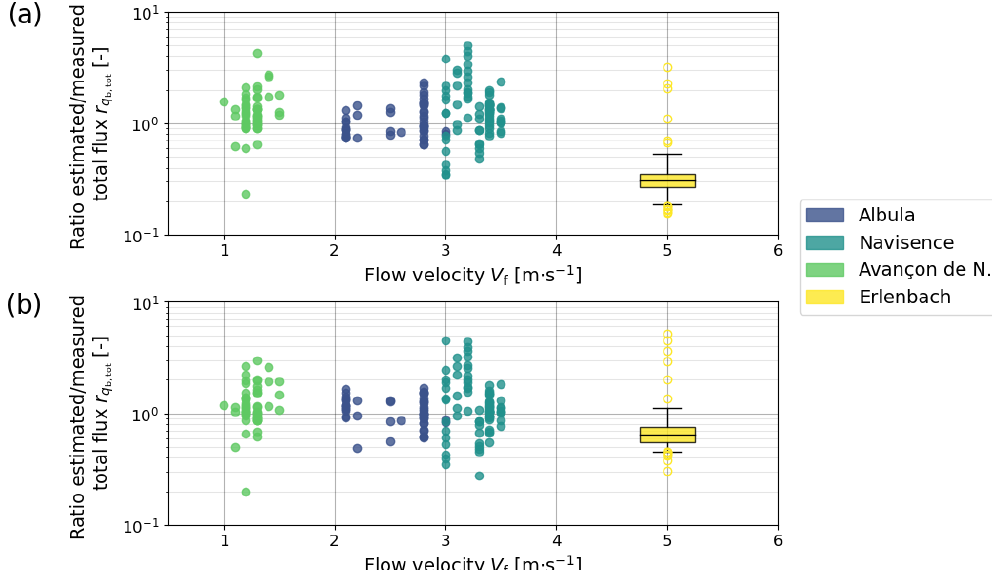
between the estimated and measured unit total mass flux as a function of the mean flow velocity V f for each collected Figure 12. Ratio r q b , tot sample and each station with the AH method (a) and the AF method (b) . The indicated flow velocity corresponds to in situ measurements performed during (or close in time to) the corresponding calibration measurement. Due to the stable flow velocity of 5ms − 1 measured at the Erlenbach site, the range of r q values is represented as a box plot. The yellow circles correspond to b , tot